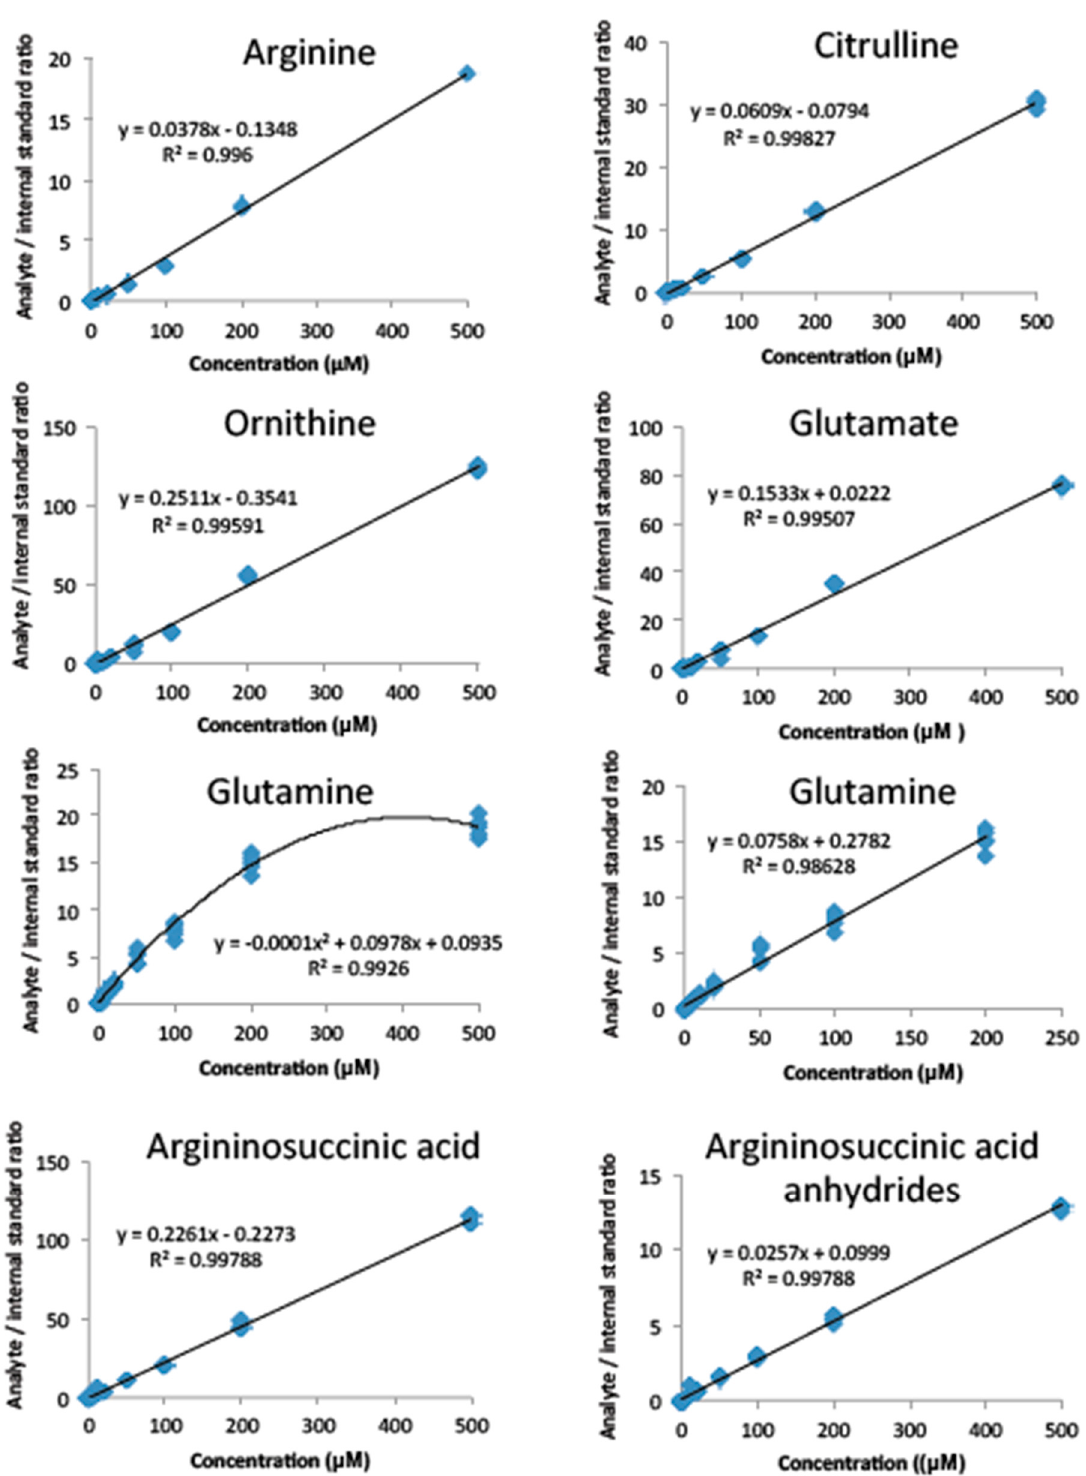
Figure 1. Linearity of measured amino acids in dried blood spots. Five calibration curves in methanol are presented. Arginine, citrulline, glutamate, ornithine, and argininosuccinic acid and argininosuccinic acid anhydrides were shown to be linear between 0 to 500 μ M and glutamine from 0 to 200 μ M.